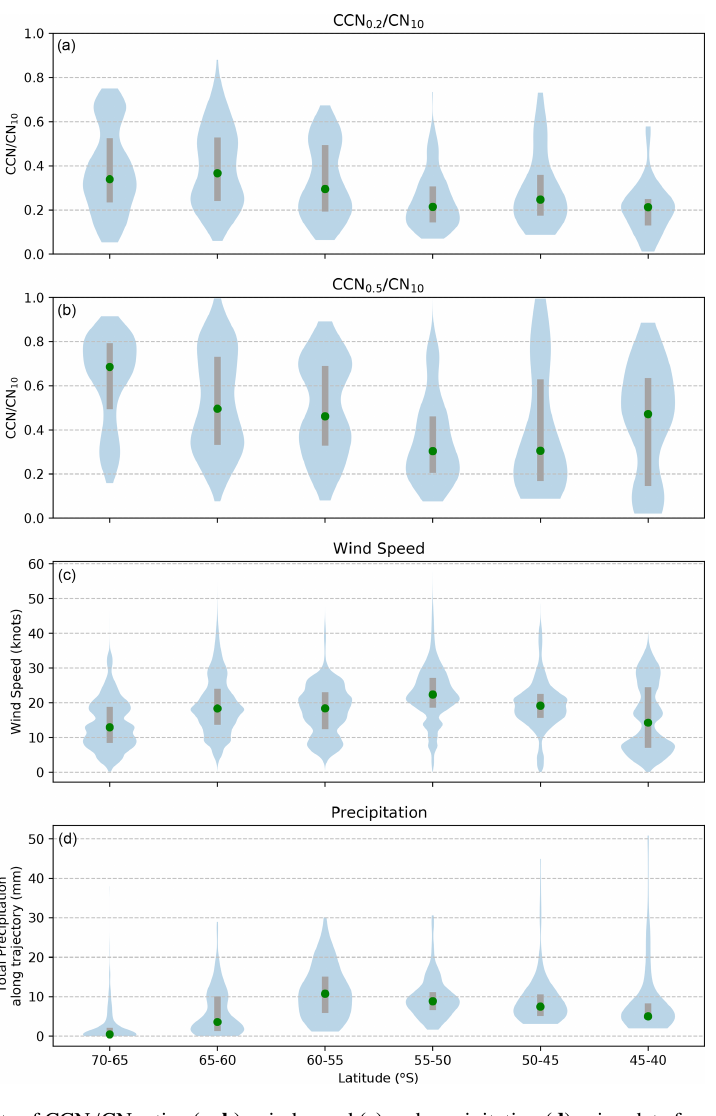
Figure A7. Latitudinal gradients of CCN / CN ratios (a, b) , wind speed (c) and precipitation (d) using data from both MARCUS and CAPRI- CORN2.